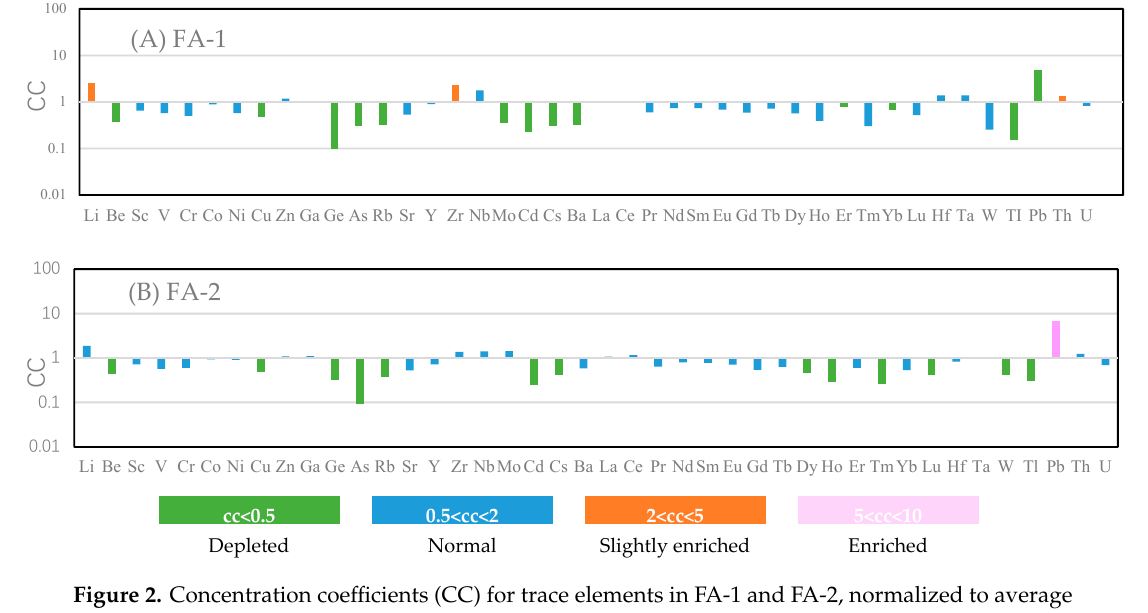
Figure 2. Concentration coefficients (CC) for trace elements in FA-1 and FA-2, normalized to average trace-element concentrations in world hard coal ashes from Ketris and Yudovich, 2009 [47].